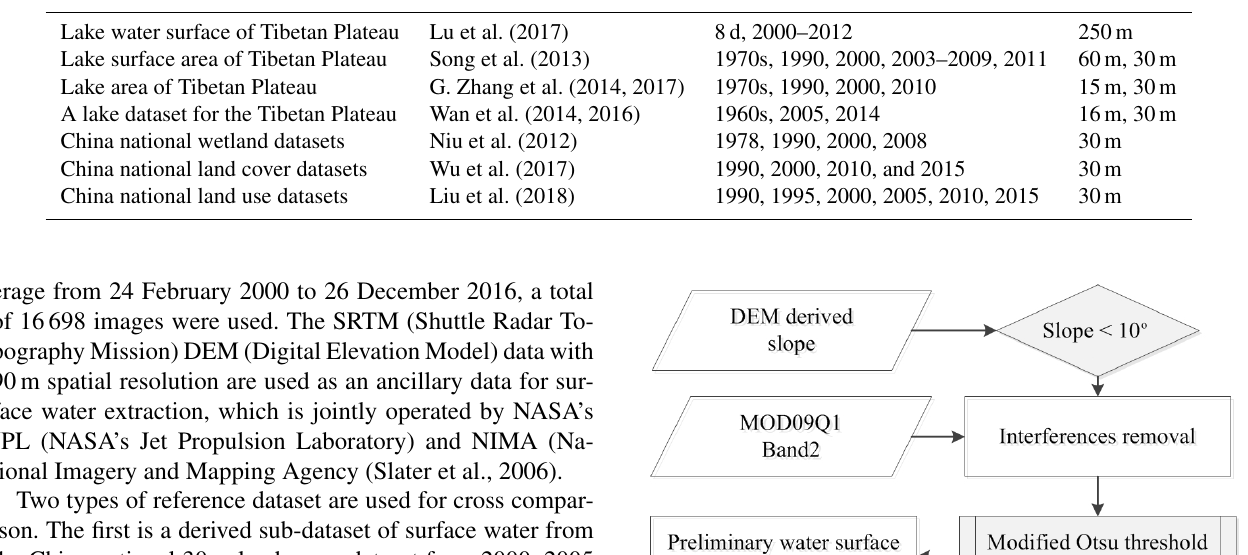
Table 1. National and regional surface-water-related datasets of China. Dataset